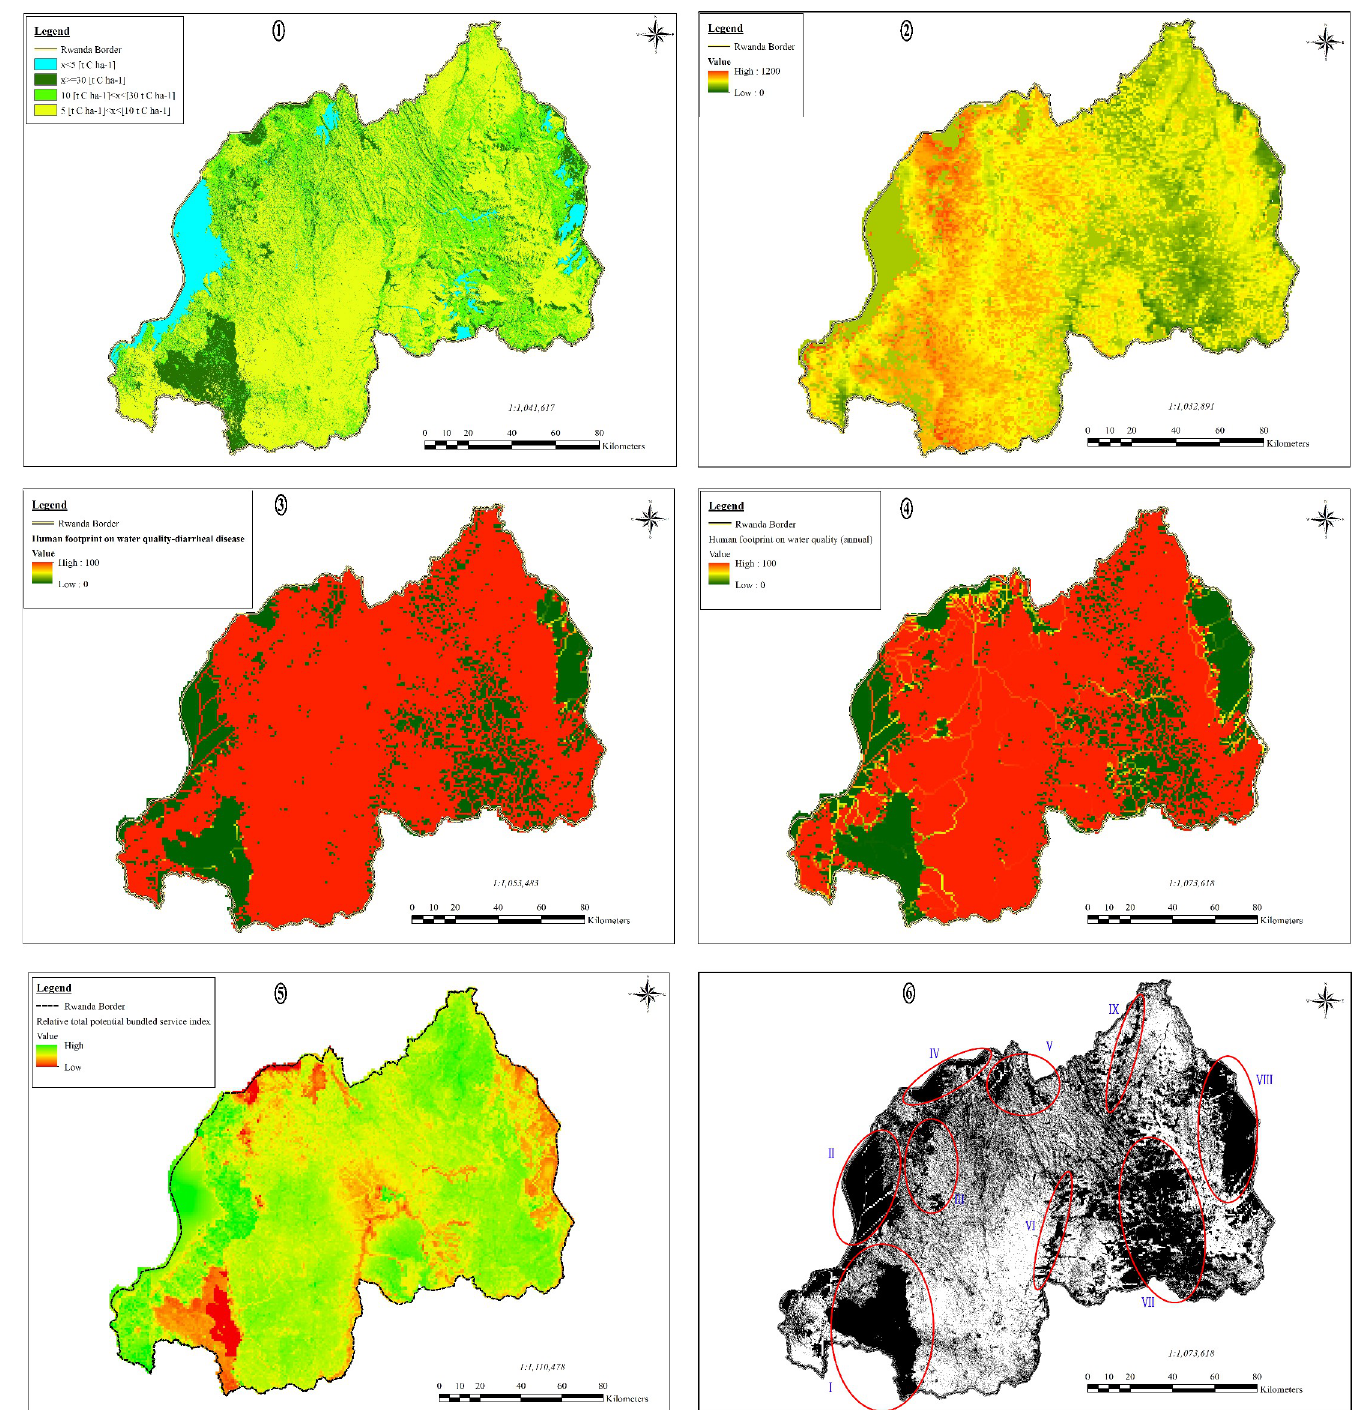
Fig 3. Distribution of ES: ① Carbon storage, ② Annual water balance, ③ Human footprint on water quality-diarrheal diseases, ④ Human footprint on water quality (annual), ⑤ Relative total potential bundled service index, ⑥ Priority areas for ES provision (I. NNP, II. Lake Kivu, III. GMNP, IV. VNP, V. Burera- Ruhondo Lake & Rugezi wetland, VI. Nyabarongo River wetlands, VII. Rweru-Mugesera wetland complex, VIII. Akagera NP, IX. Muvumba wetland).